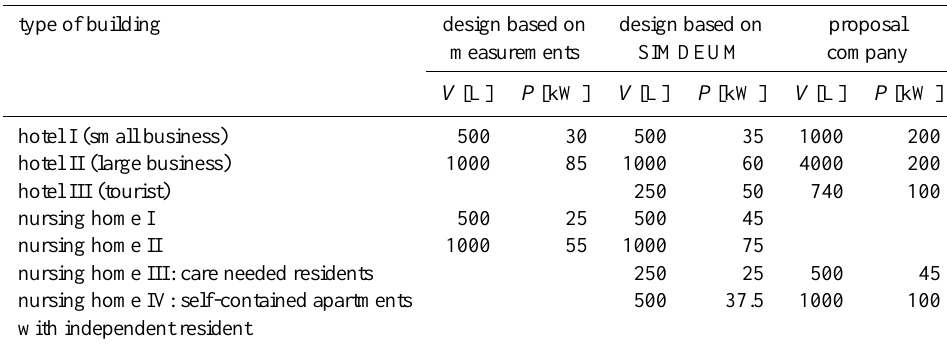
Table 10. Dimensions of heating systems for di ff erent type of buildings, based on measured hot water demand, based on SIMDEUM based design-demand-equations and proposed by companies. type of building design based on design based on proposal measurements SIMDEUM